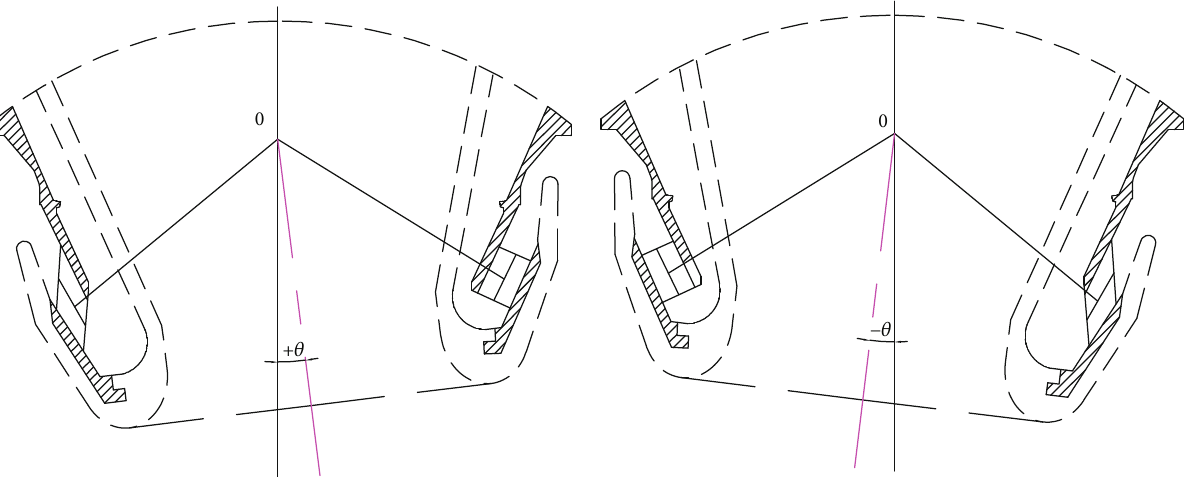
Figure 2: Shear deformation process of a fl exible joint.